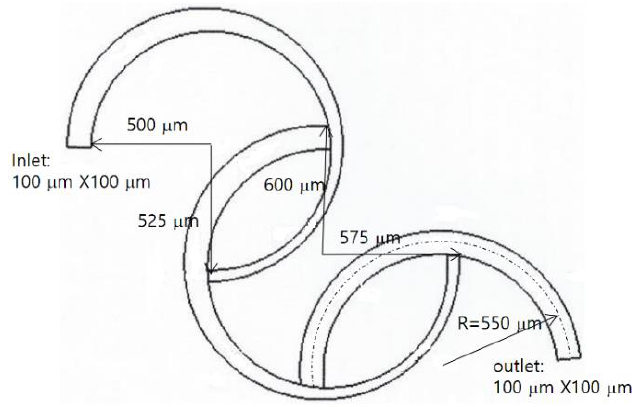
Figure 2. Diagram of the SAR examined by Sheu et al. [26].